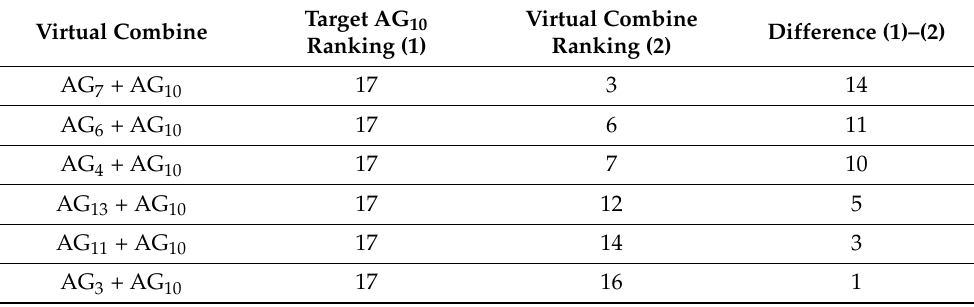
Table 17. The good alliances cooperative.